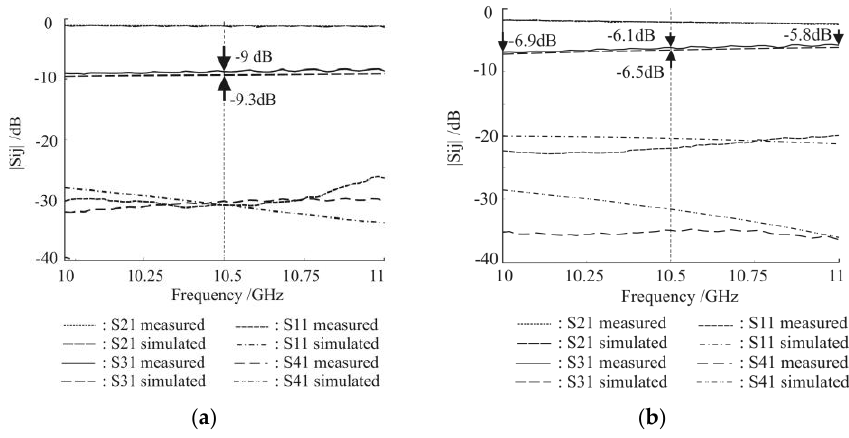
Figure 5. Simulated and measured frequency response: ( a ) standard quarter-wave, coupled-line-directional coupler of Figure 4, left; the simulated S41 is below −40 dB ( b ) proposed directional coupler of Figure 4, right.